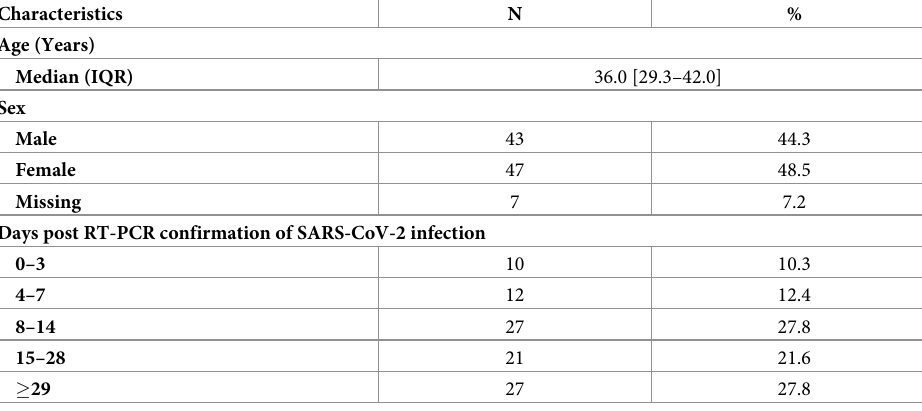
Table 1. Characteristics of SARS-CoV-2 RT-PCR positive